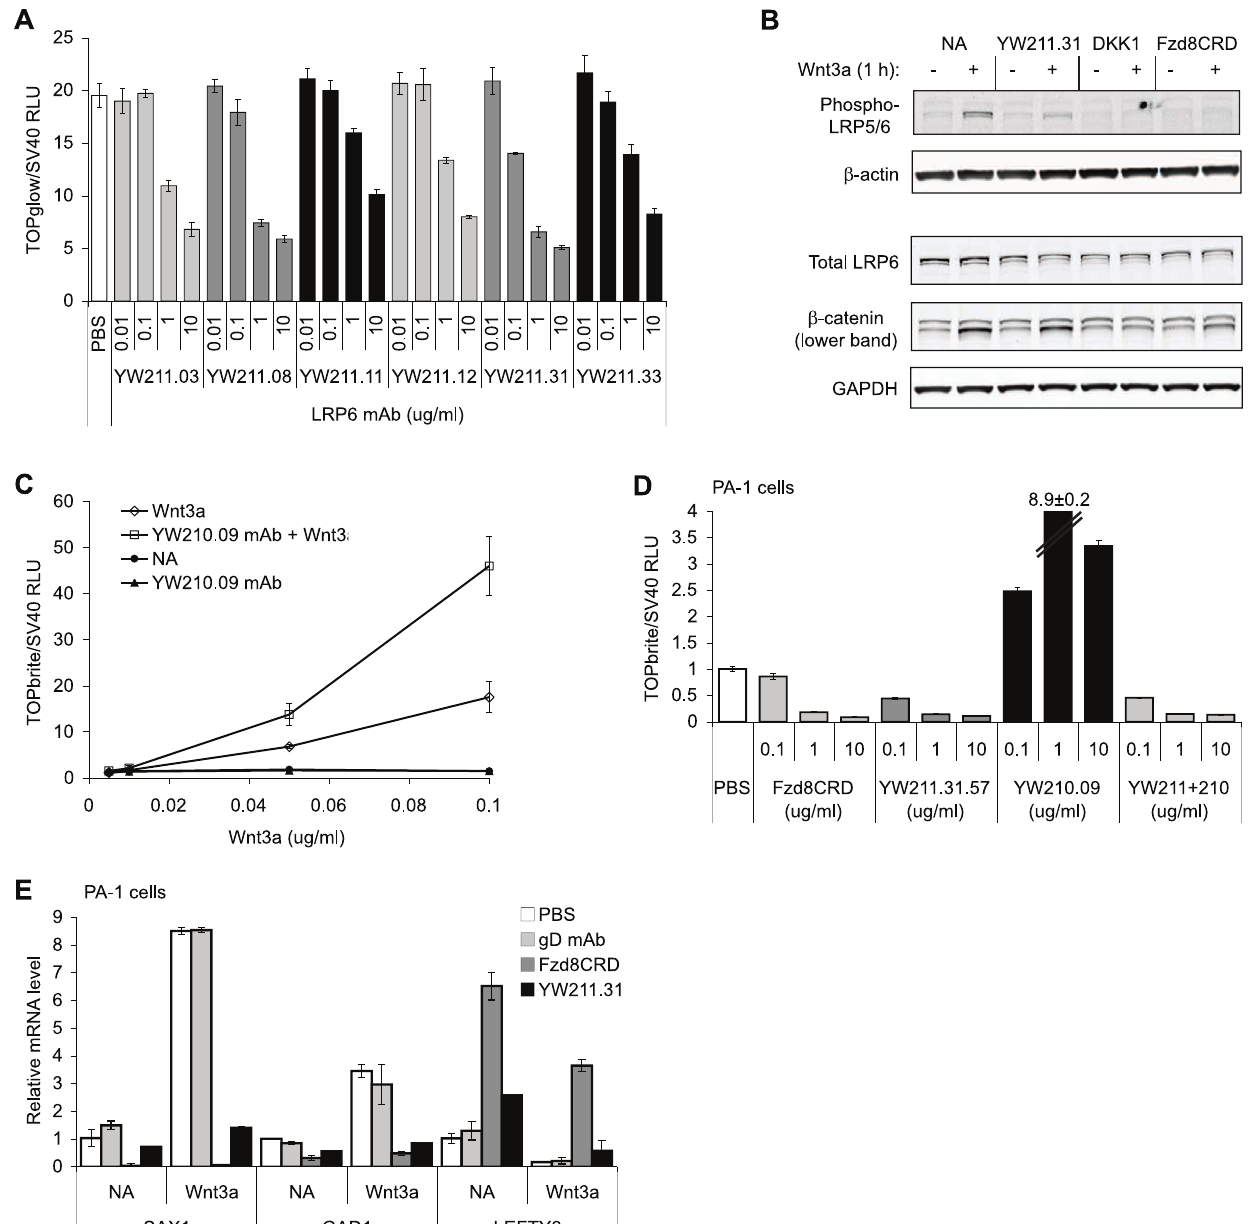
Figure 1. LRP6 monoclonal antibodies antagonize and potentiate Wnt3a-induced signaling and teratocarcinoma autocrine Wnt signaling. (A) Six antibodies against LRP6 E3-E4 protein fragment inhibit in a concentration-dependent manner the Wnt luciferase reporter activity in HEK293 cells induced with 0.1 m g/ml purified Wnt3a. Error bars of this and all other graphs, except where noted, represent standard deviation of at least 3 replicate samples. (B) Western analysis of HEK293 cells either unstimulated ( 2 ) or induced ( + ) with Wnt3a and treated with the indicated LRP6 antibody or purified protein. RNAi experiments demonstrate that only the lower molecular weight band recognized by the b -catenin polyclonal antibody represents b -catenin protein (data not shown). b -actin and GAPDH protein levels are shown as sample loading controls for the upper and lower gels, respectively. (C) YW210.09 antibody potentiates Wnt reporter gene activity in a manner proportional to Wnt3a concentration in HEK293 cells (NA indicates no addition of Wnt3a or antibody). (D) Concentration-dependent inhibition and potentiation of autocrine Wnt signaling in PA-1 teratocarcinoma cells transfected with luciferase reporters and treated with LRP6 antibodies, either individually or in combination, or with Fzd8CRD- Fc protein. (E) qPCR expression analysis of Wnt-induced genes SAX1 and GAD1 and Wnt-repressed gene LEFTY2 in PA-1 cells treated with or without (NA) 0.3 m g/ml Wnt3a protein, and treated with 10 m g/ml YW211.31 antibody, anti-gD monoclonal antibody as a negative control, or Fzd8CRD-Fc protein as a positive control. both YW211.31.57 and YW210.09 antibodies antagonizes both Wnt3a-induced and autocrine Wnt signaling, similar to the effect of YW211.31.57 alone (Figure 1D).